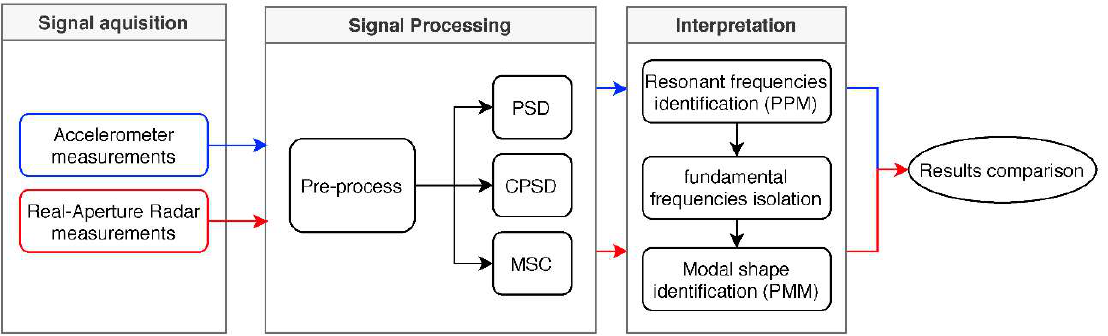
Figure 1. Flowchart of the main steps involved in the dynamic monitoring procedure. The blue and red colors indicate, respectively, accelerometer and real-aperture radar (RAR) signal input/output.